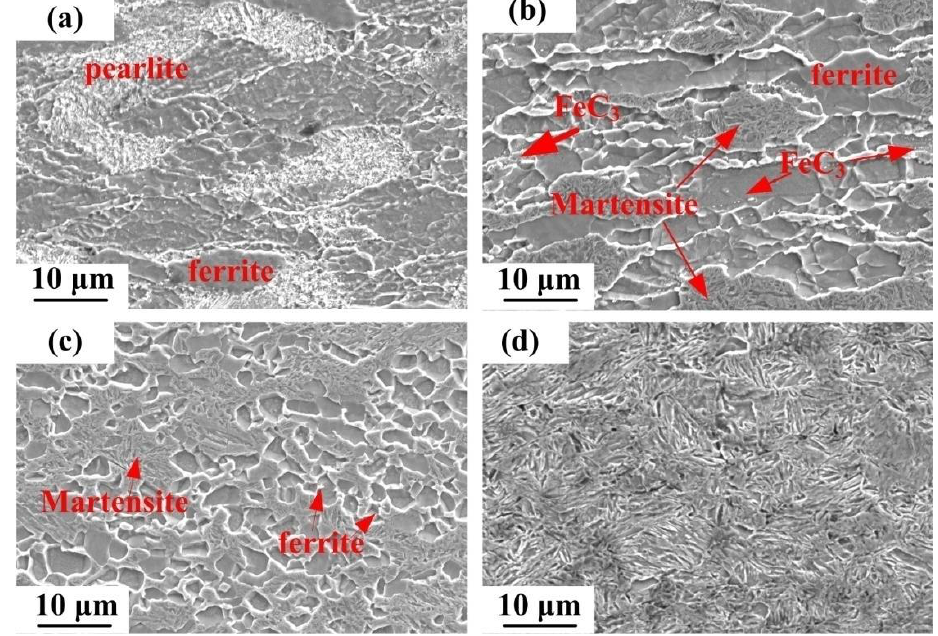
Figure 3. Low magnification SEM images of ( a ) 700 °C, 0.01 s −1 ( b ) 750 °C, 0.01 s −1 ( c ) 800 °C, 1 s −1 ( d ) 850 °C, 1 s −1 .